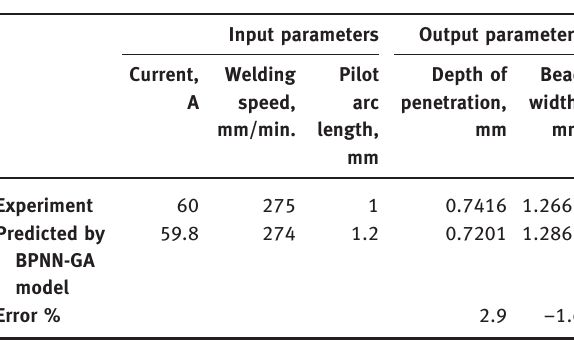
Table 11: Plasma arc welding process parameters and error of con- firmation